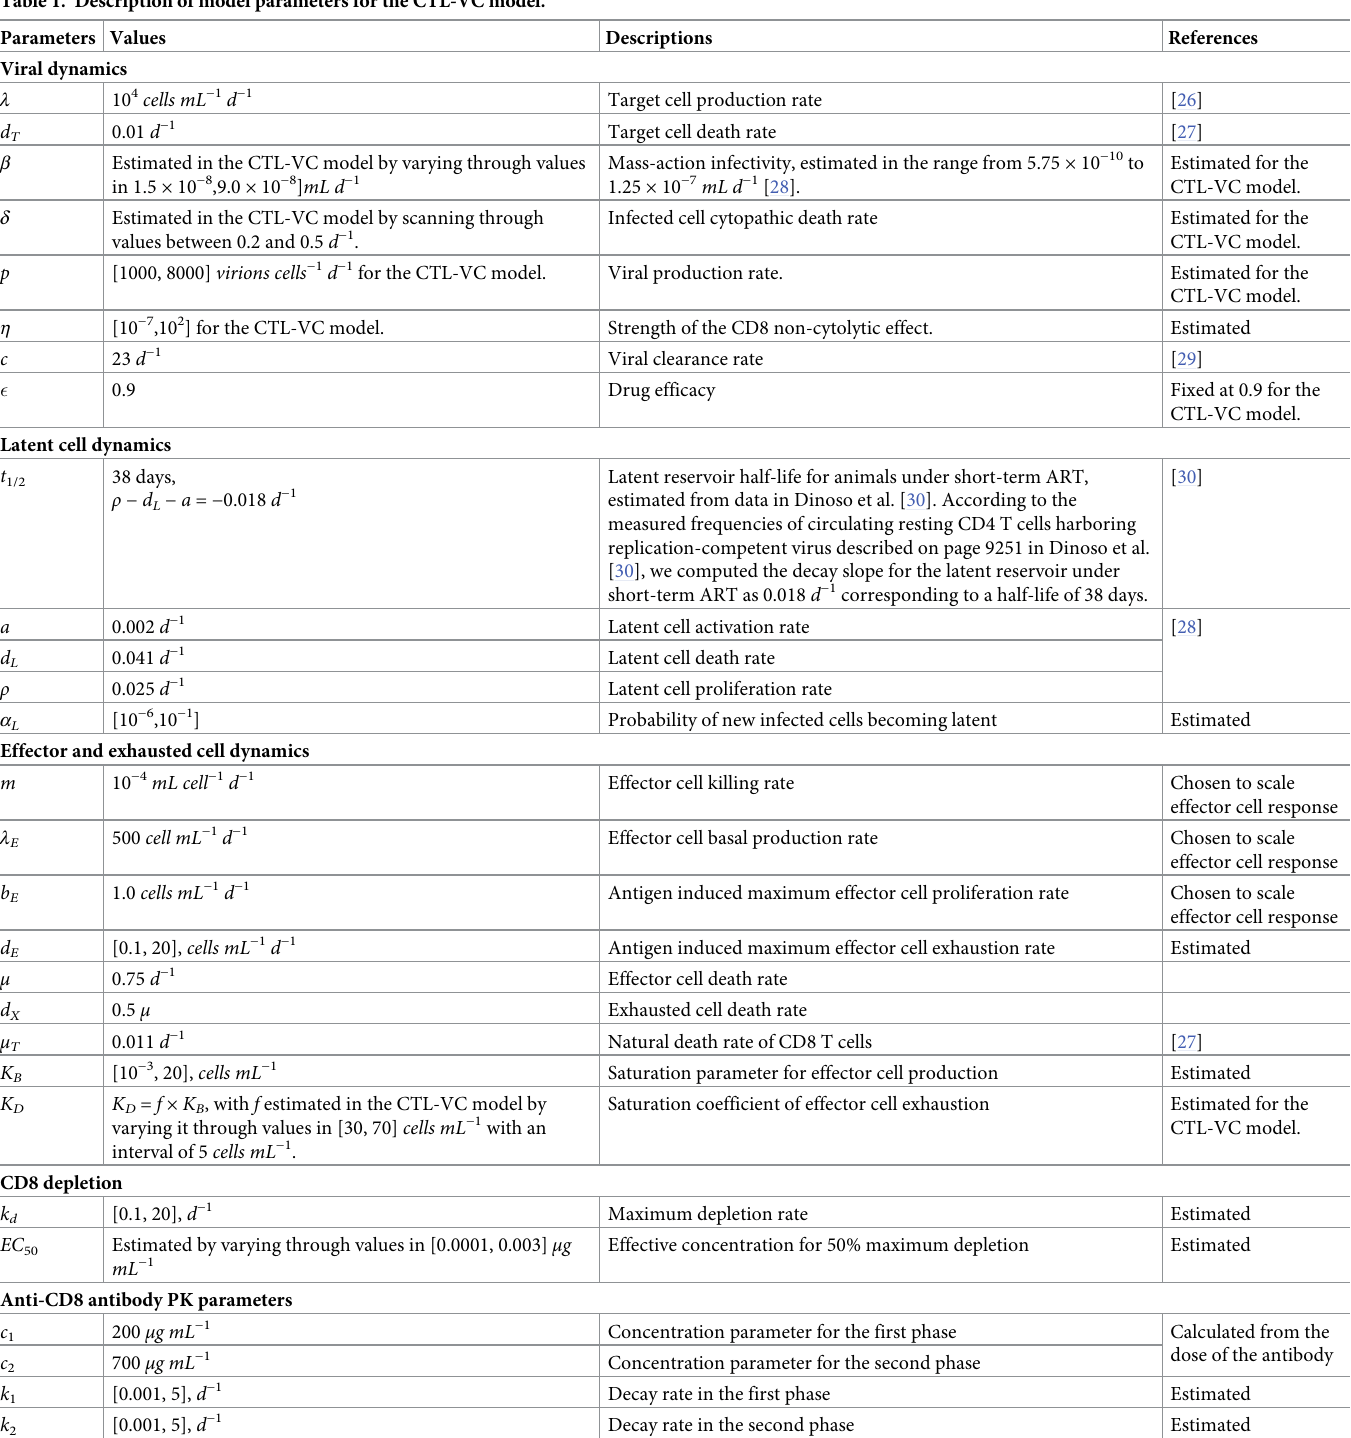
Table 1. Description of model parameters for the CTL-VC